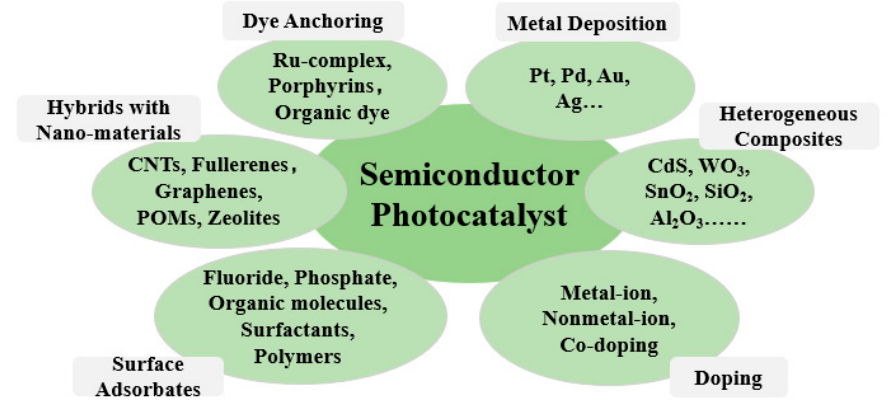
Figure 2. Various modification methods of a semiconductor photocatalyst.